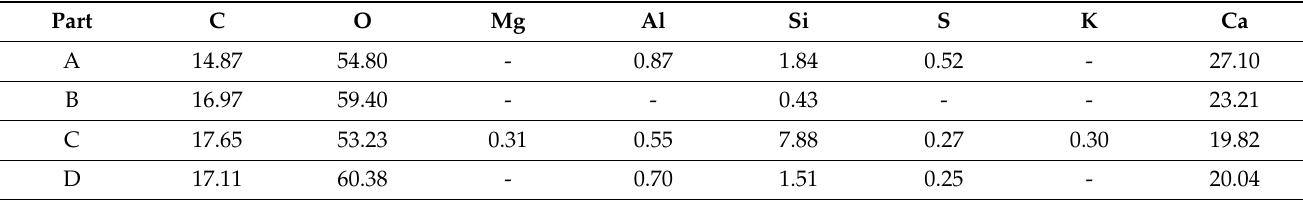
Table 5. The element distribution obtained by EDS (%).